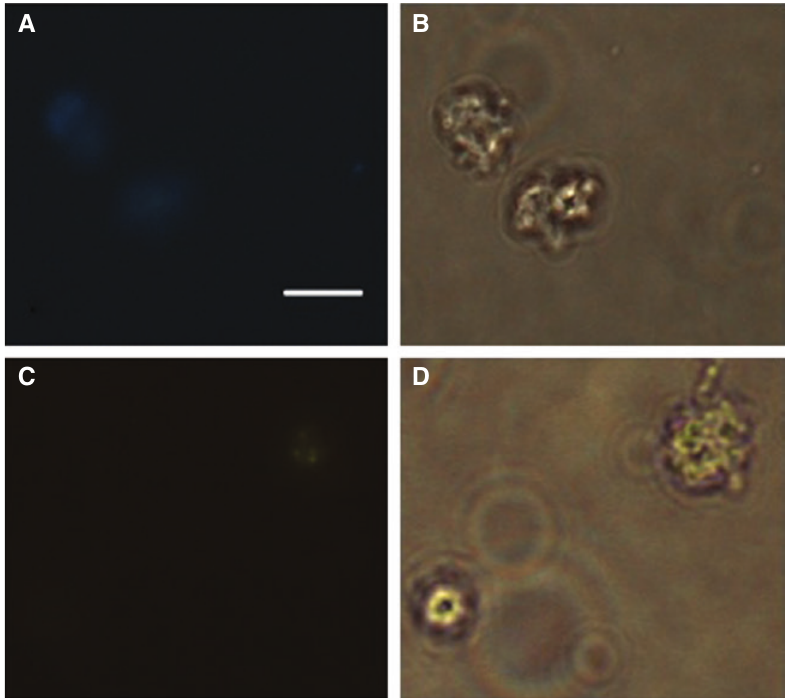
Figure 3: Auto-fluorescent vacuoles and lysosomes in stationary phase cells. (A) Fluorescence microscopy images of auto-fluorescent vacuoles and (B) light field microscopy of the same cells. (C) Fluorescence micros- copy images of lysosomes stained with NBD-PZ and (D) light field microscopy images of the same cells. Scale bar = 10 μ